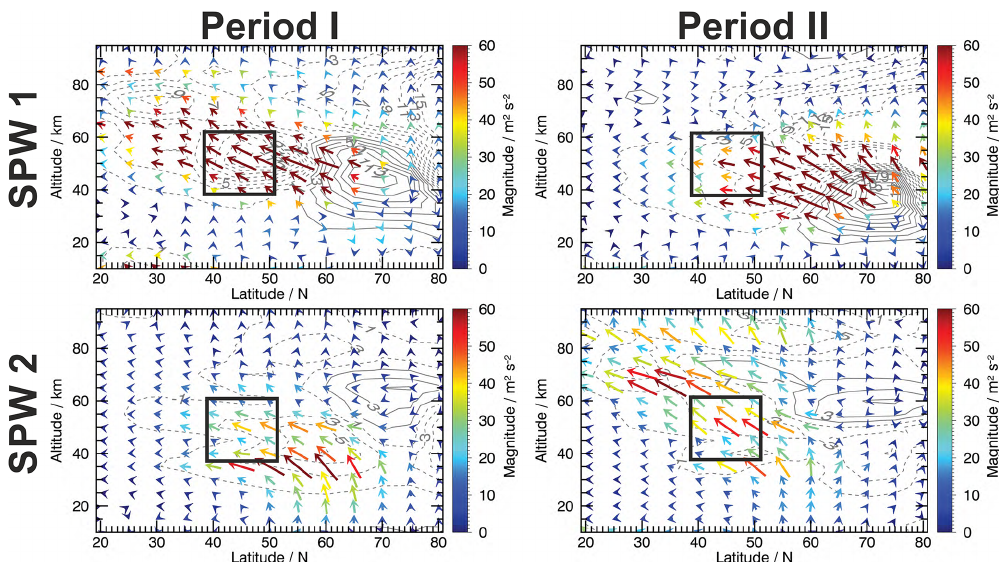
Figure 4. Same as Figs. 2c and 3c but for the SPW 2 in Period I and SPW 1 in Period II. The black rectangles mark the areas crucial for upward propagation of the SPWs into the subtropical